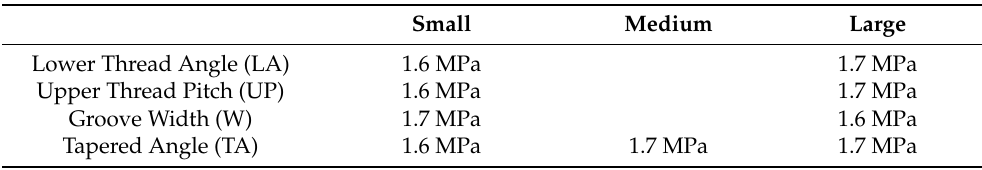
Table 9. Comparison of average stress on the second layer of the reverse buttress part of test block of four different design factors in 10